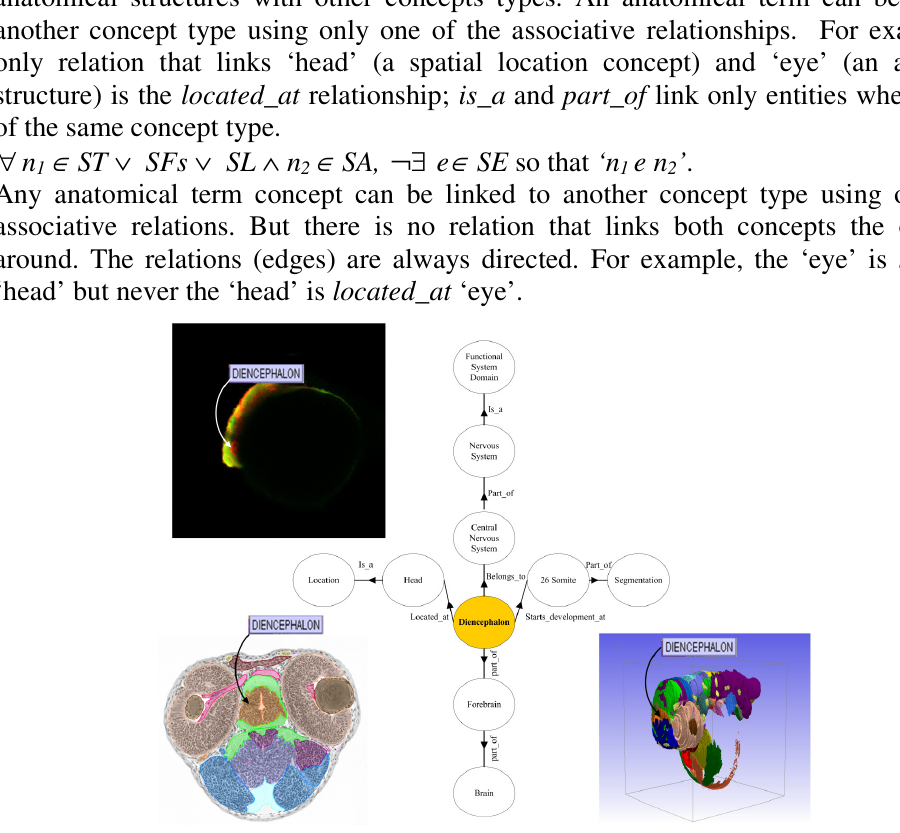
Figure 2: The diencephalon hierarchical organization to show the DAG structure of the anatomy ontology. This structure is inherited by the annotated images, e.g. top left: msxb gene expression pattern in a 24 hours post fertilization (hpf) zebrafish embryo, 2D projection of a 3D CLSM image. 3D model from the atlas (lower left: 2D view; lower right: 3D view of a 48 hpf. zebrafish